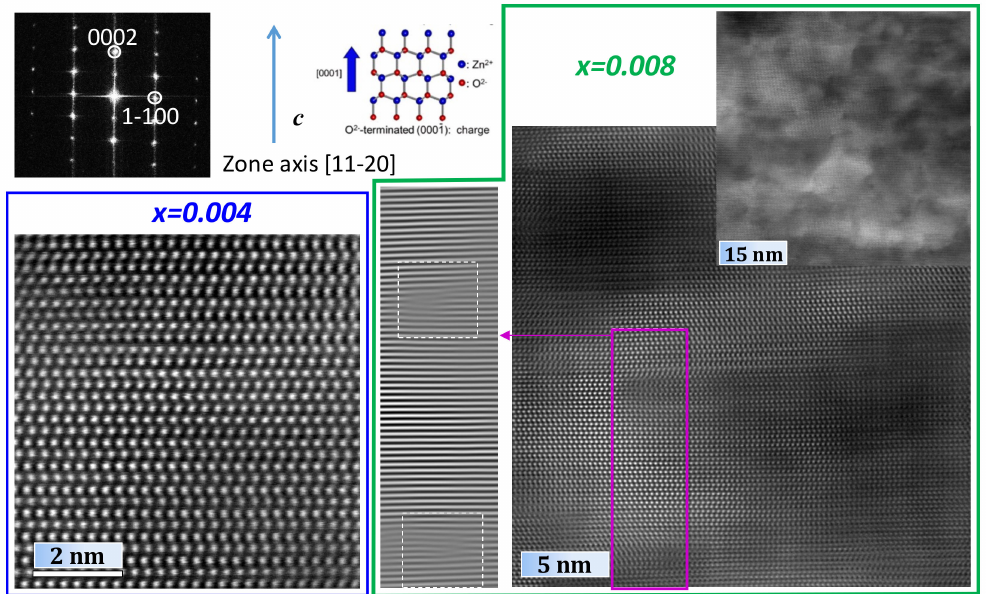
Figure 2. Selected area electron di ff raction (SAED) pattern and HRSTEM-HAADF images obtained for x = 0.004 (blue line square) and 0.008 (edged by a thicker green line) samples. While sample with x = 0.004 shows homogeneous contrast, the contrast for x = 0.008 sample is rather inhomogeneous, with strain studies showing its origin in dislocations defects (left part edged by the green